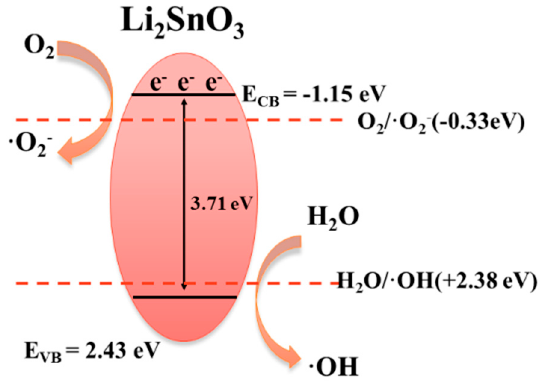
Figure 8. Schematic illustration of the proposed photocatalytic mechanism.